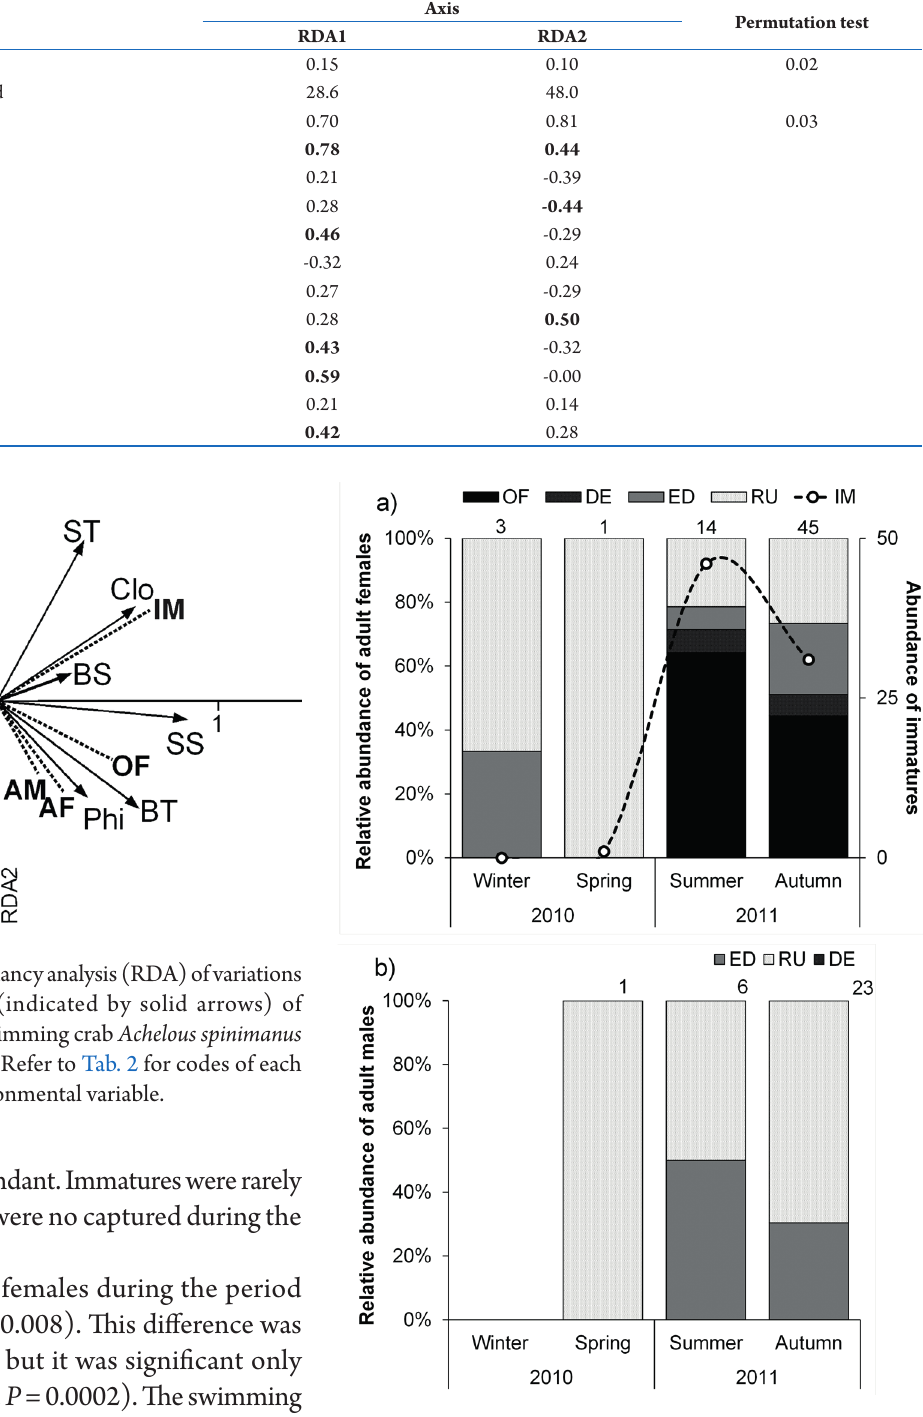
Figure 3 . Seasonal variation in the proportion of (a) adult females and (b) adult males of the swimming crab Achelous spinimanus in different gonadal stages from the upwelling region off Macaé in southeastern Brazil. OF = ovigerous females, DE = developed gonads, ED = developing gonads, RU = rudimentary gonads, and IM =